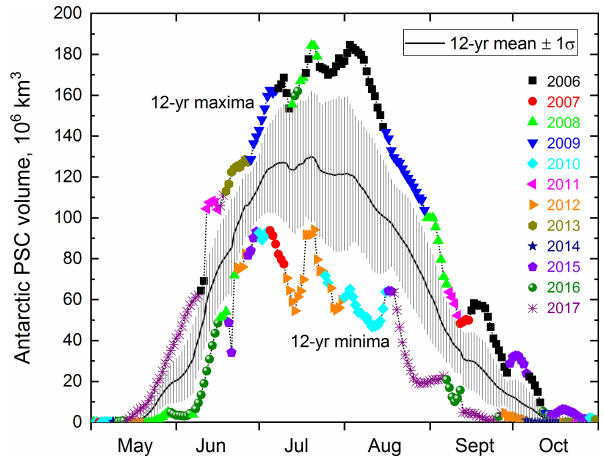
Figure 15. Time series of the 12-year mean, standard deviation, and range of daily values of Antarctic PSC spatial volume (daily areal coverage integrated over altitude). The daily maximum and minimum values are color-coded according to the year in which they